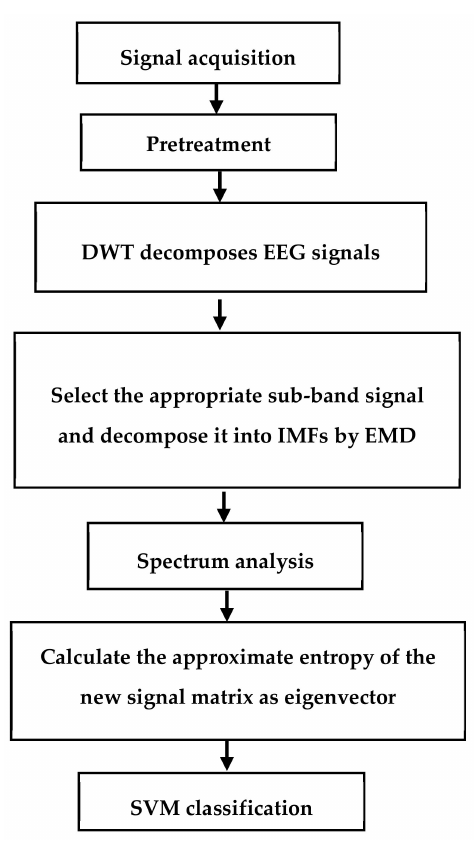
Figure 1. Algorithm flowchart.